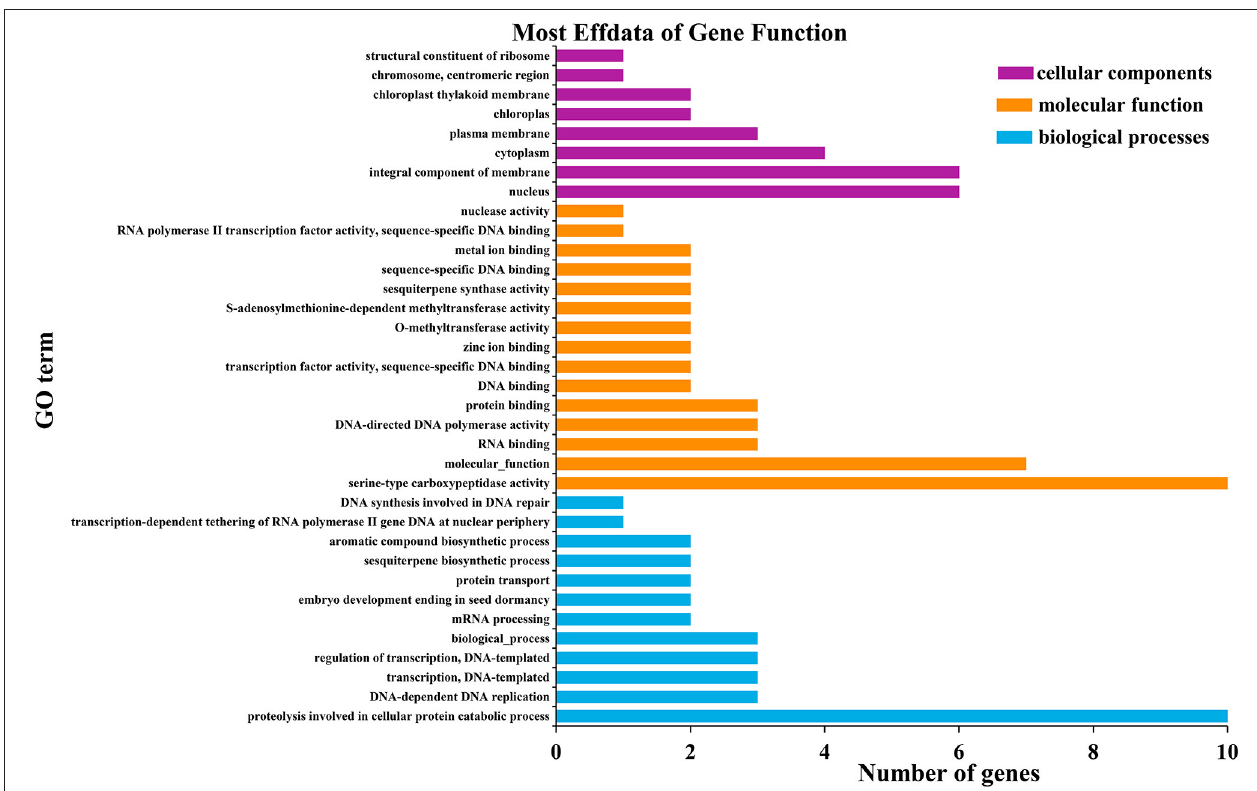
FIGURE 3 | Significantly enriched GO terms of the genes around qHTT8 .